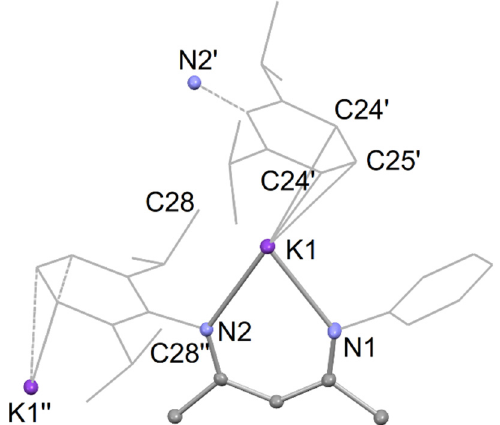
Figure 4. Partial thermal ellipsoid plot (25% probability surface for displayed ellipsoids) of the molecular structure of 7 (hydrogen atoms omitted; Dip groups shown as wireframe, and TCHP group truncated for clarity). Selected bond lengths (Å) and angles (°): K(1)-N(1) 2.634(3), K(1)-N(2) 2.713(3), K(1)-C(24)’ 3.254(3), K(1)-C(25)’ 3.178(4), N(1)-K(1)-N(2) 68.82(9) .